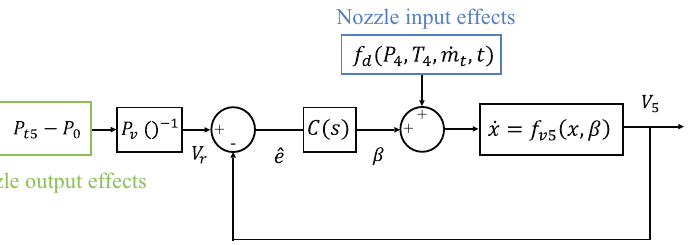
Figure 6. Simplification of the controller structure, segregating into the effects of the nozzle input (gas properties from the turbine output), and the nozzle output (gas expansion